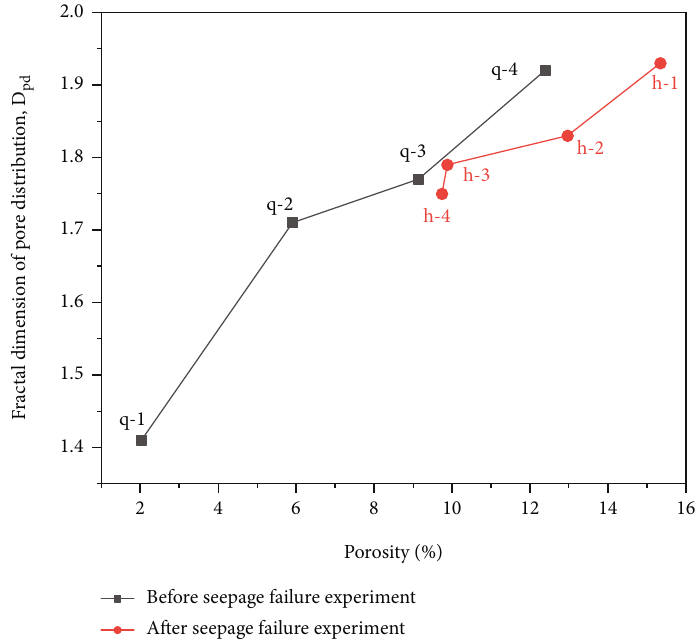
Figure 10: Relationship between porosity and D